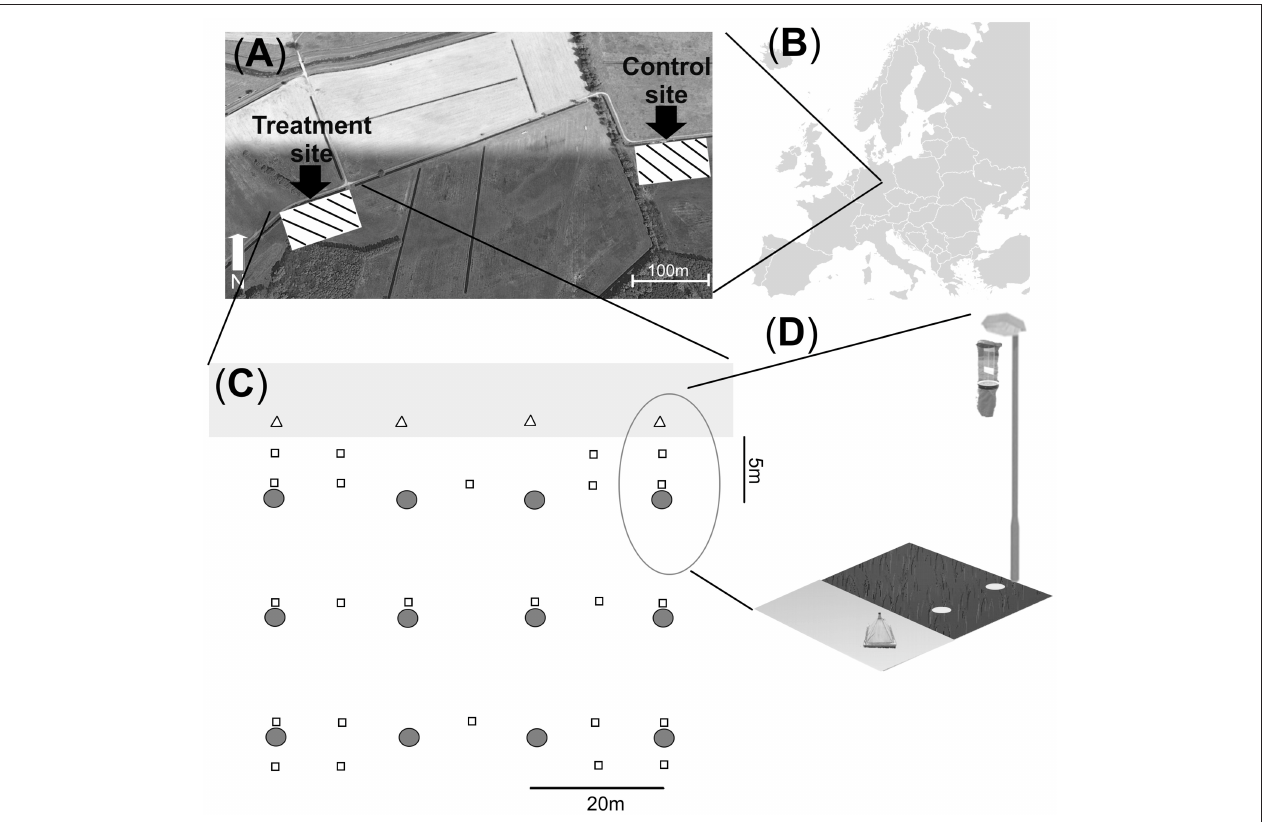
FIGURE 1 | Study area in the Westhavelland (Brandenburg; 52 ◦ 41 ′ 29.81 ′′ N, 12 ◦ 27 ′ 37.54 ′′ E) depicting Treatment and Control sites (each 60 × 40m) located along an agricultural drainage ditch (A,B) . The lower panels (C,D) depict the Treatment site with streetlamps and sampling traps. Floating pyramidal emergence traps (triangles, n = 4) were placed adjacent to a lamp on the water surface of the drainage ditch. Air eclector traps were mounted below each lamp (grey circles, n = 12). Pitfall traps (quadrats, n = 24) were placed on the ground in multiple locations. The structural design of the Control site was identical to the Treatment site, yet streetlights were not switched on. Map data by Google Earth Pro (2011) 1 (A) and Wiki-vr (https://en.wikipedia.org/wiki/File:Europe_blank_map.png) (B)